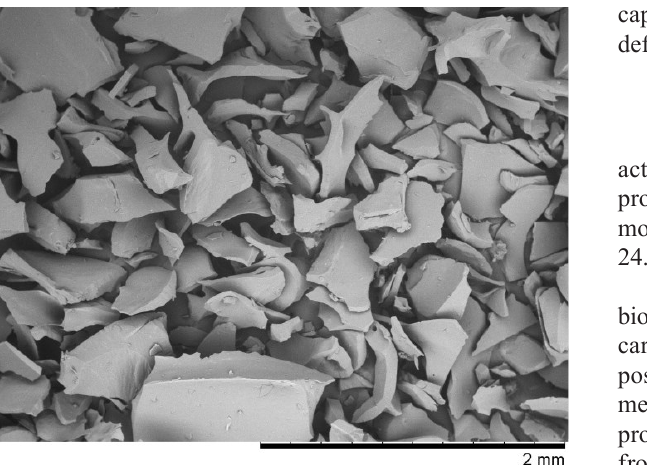
Figure 9 Scanning electron microscopy of the material after vacuum